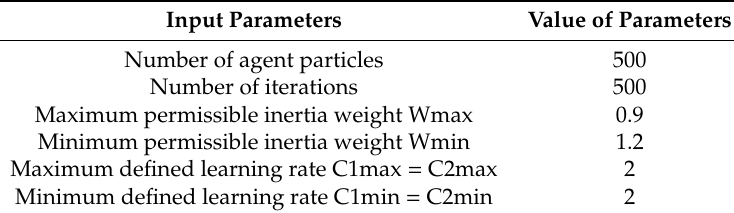
Table 4. Initial parameters of the PSO algorithm.